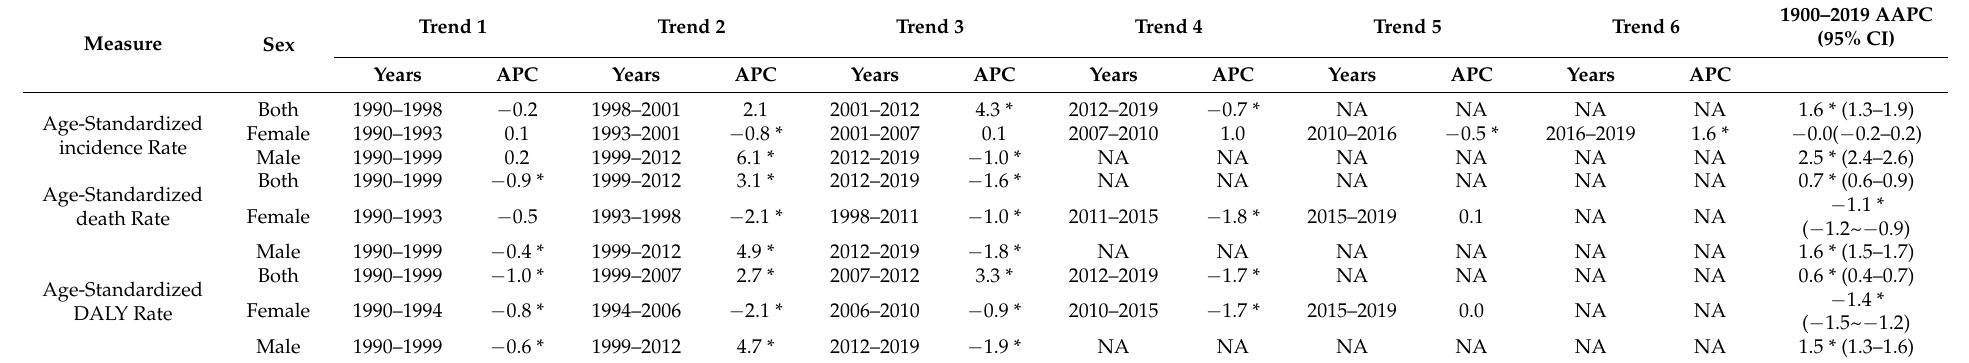
Table 1. The log-transformed joinpoint trends of lip and oral cavity cancer ASRs by sex in